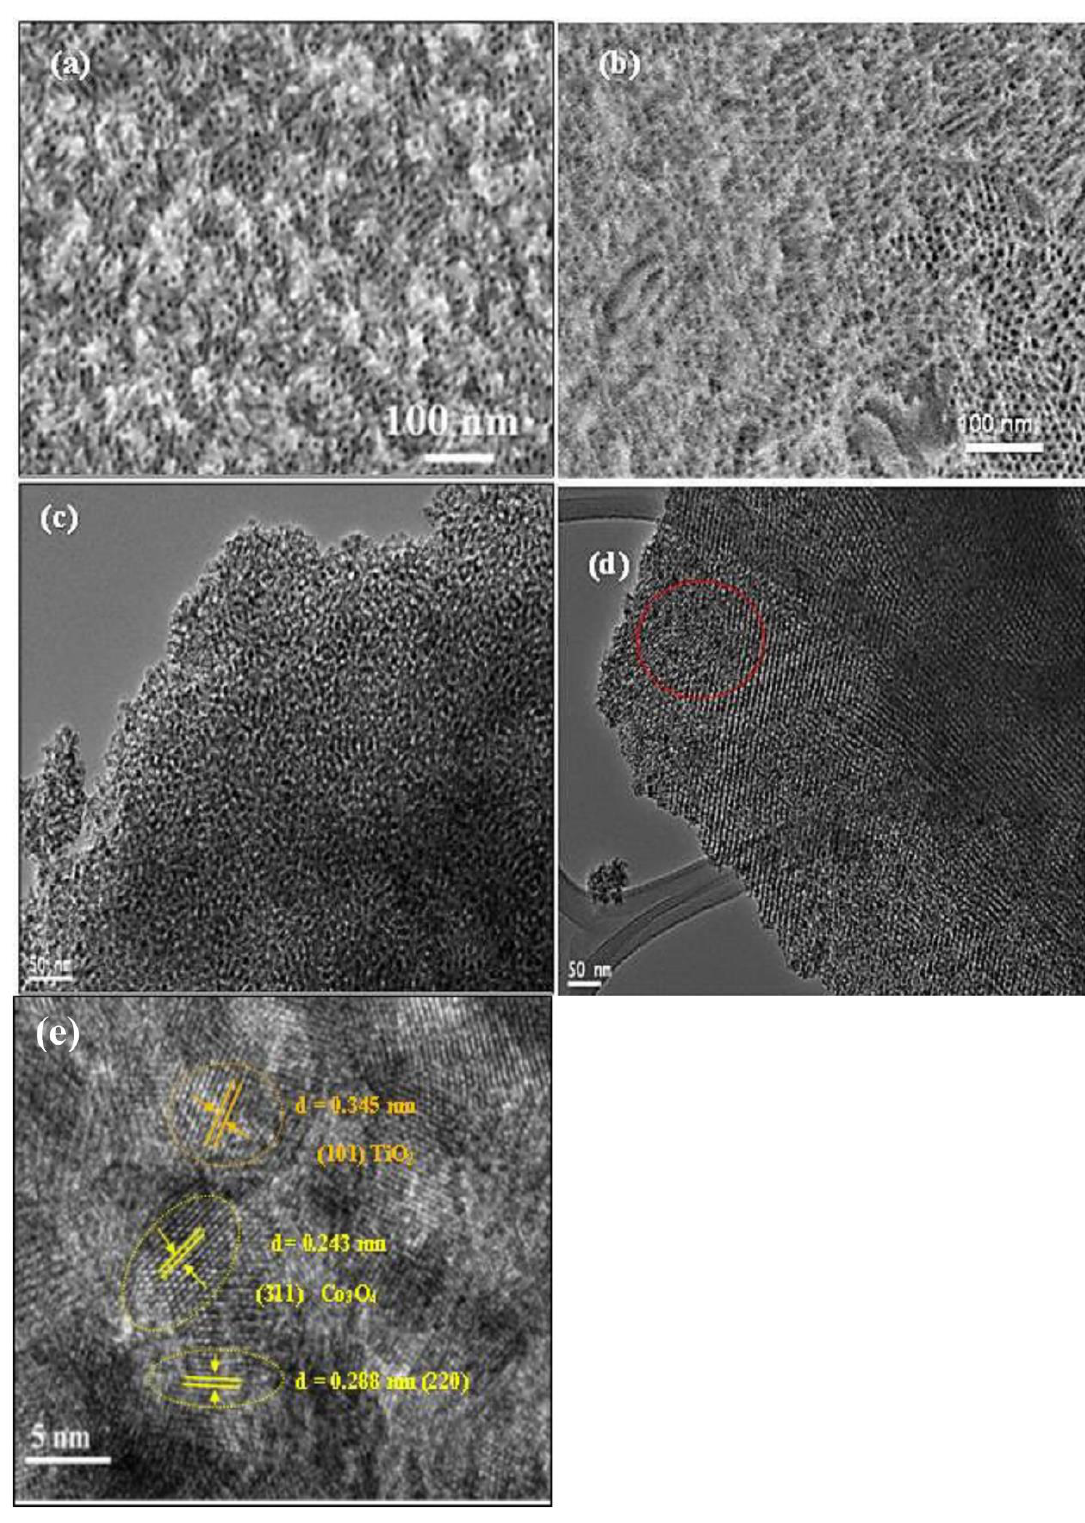
Figure 23. SEM images of ( a ) Co 3 O 4( 3)/lsm-TiO 2 and ( b ) Co 3 O 4 (3)/hm-TiO 2 ; typical TEM images of ( c ) Co 3 O 4 (3)/lsm-TiO 2 and ( d ) Co 3 O 4 (3)/hm-TiO 2 ; and ( e ) high resolution TEM of Co 3 O 4 (3)/hm-TiO 2 hybrid. (Reprinted with permission from [297]. Copyright 2019, MDPI).